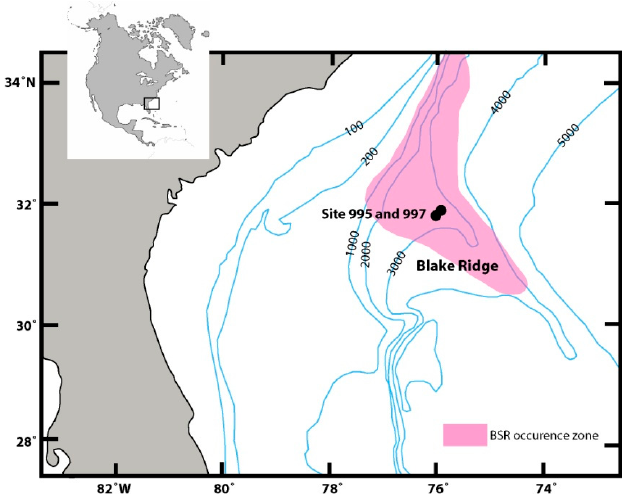
Figure 1. Bathymetric map of the Blake Ridge gas hydrate province including drill Site locations of Ocean Drilling Program (ODP) Leg 164 (modified after Dillon and Paull [39]). Bathymetry contours are presented in meters. The shaded area (in pink) depicts the BSR occurrence.